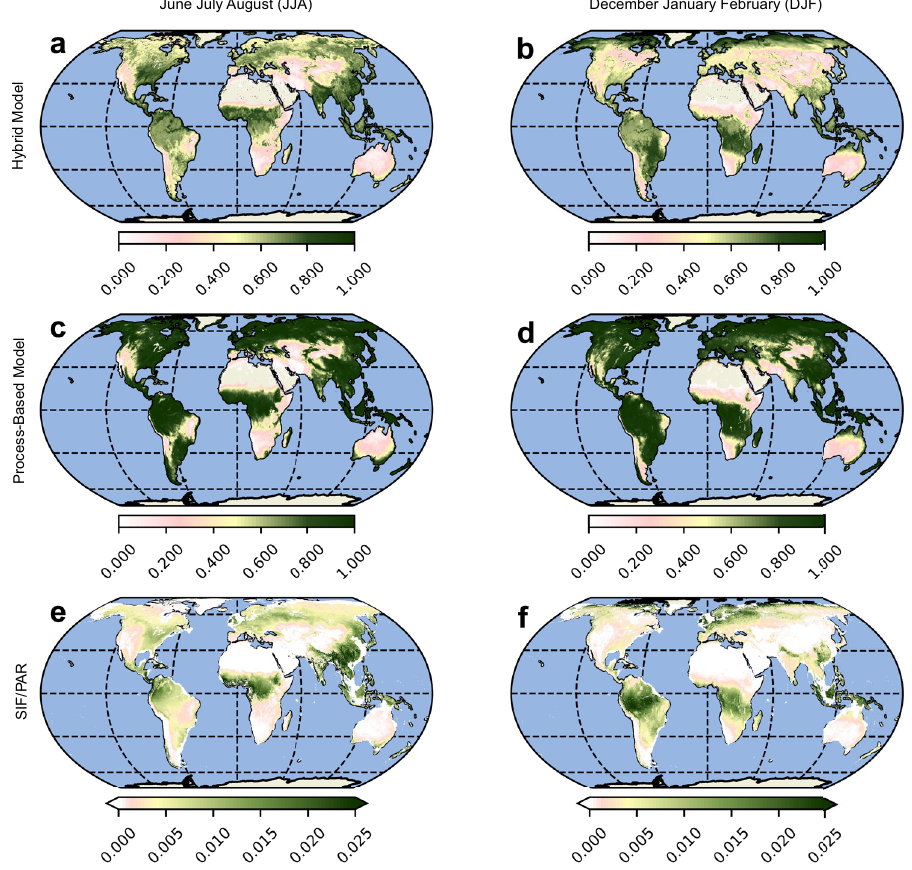
Fig. 4 Global scale evaluation of modeled transpiration stress. Comparison of the seasonal mean transpiration stress factor ( S t ) from the processed- based and hybrid models and the ratio of solar-induced chlorophyll fl uorescence and photosynthetically-active radiation ( SIF / PAR ) for June-July-August (JJA) a , c , e and December-January-February (DJF) b , d , f seasons. Note: The unit of measurement of SIF is mWm 2 / sr / nm whereas PAR is in W / m 2